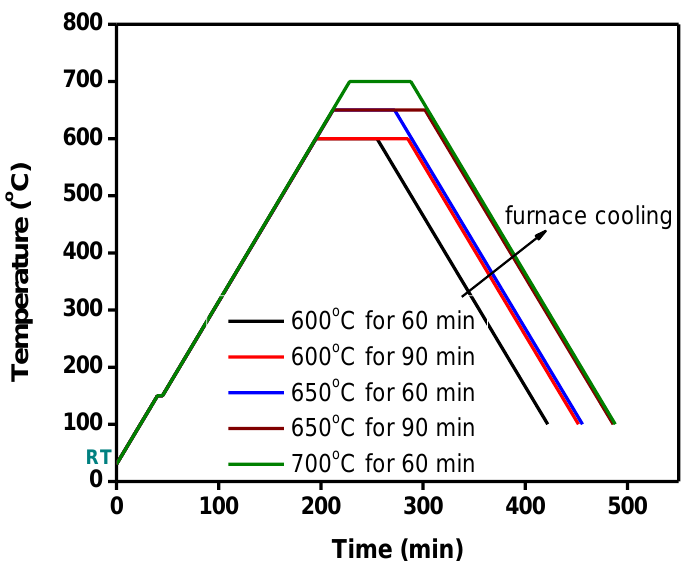
Figure 1. Sintering cycles for the aluminum metal matrix composites (Al MMCs).